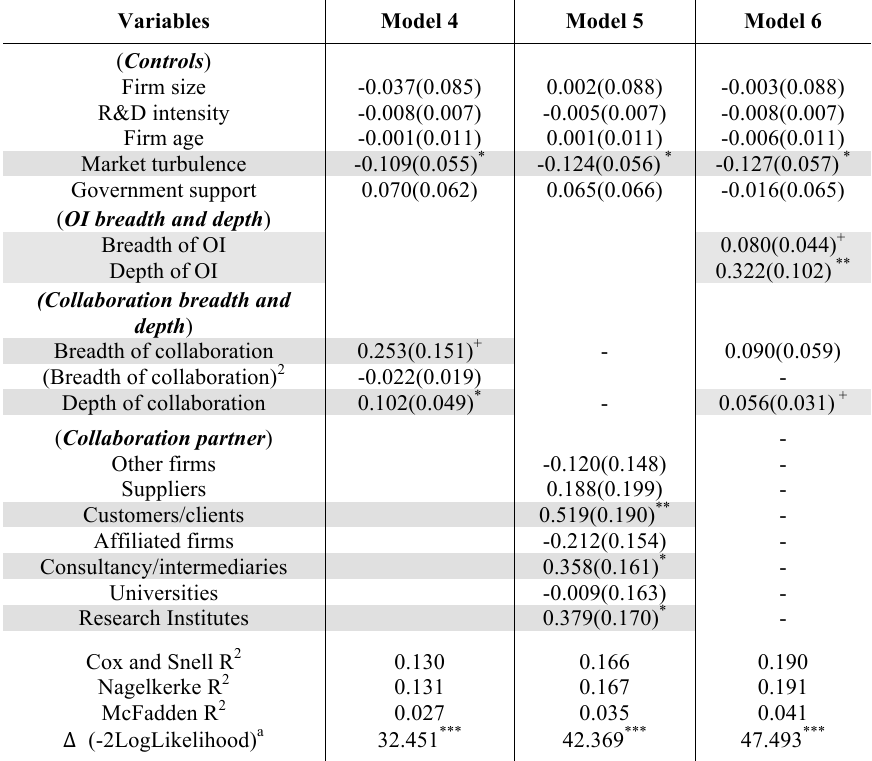
Table 5. OI partners and firm